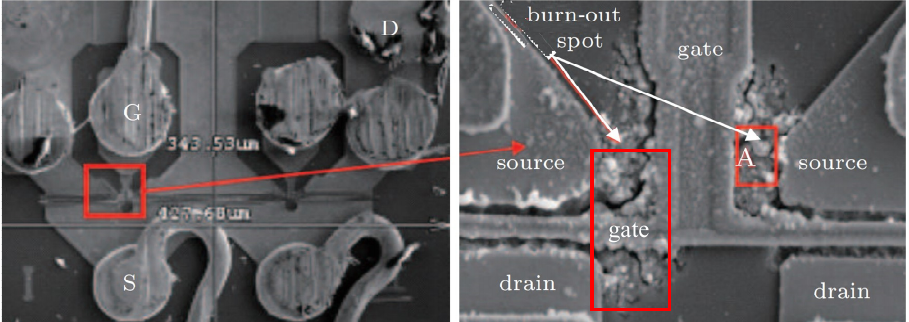
Figure 14. Interior features of damaged samples, characterized by SEM.